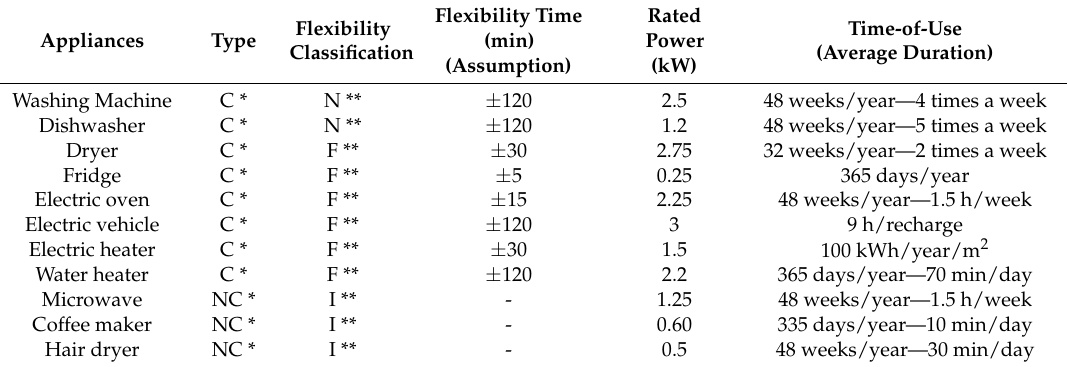
Table 4. Example of classification of the electrical appliances in a smart home